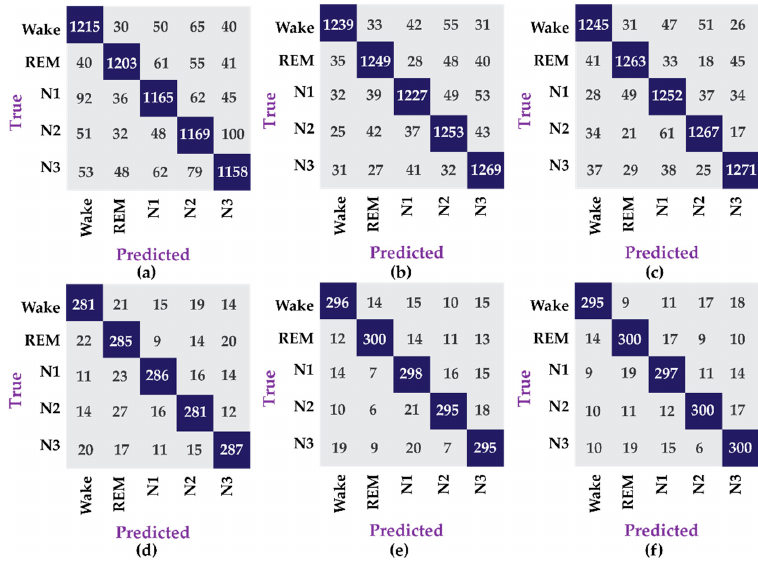
Figure 5. Confusion matrix for different datasets, i.e., ( a ) dataset 1, ( b ) dataset 2, ( c ) dataset 3, ( d ) dataset 4, ( e ) dataset 5, and ( f ) dataset 6.